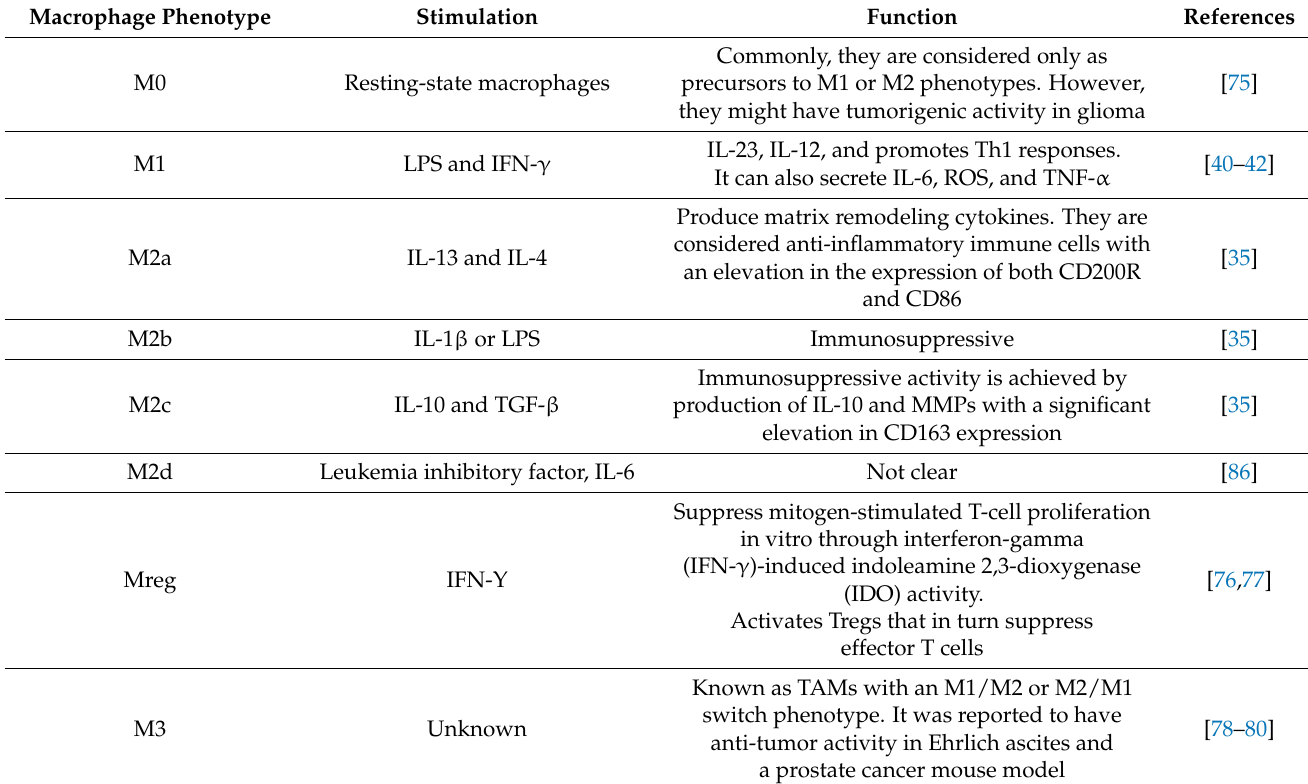
Table 2. An overview of the monocyte-derived macrophage